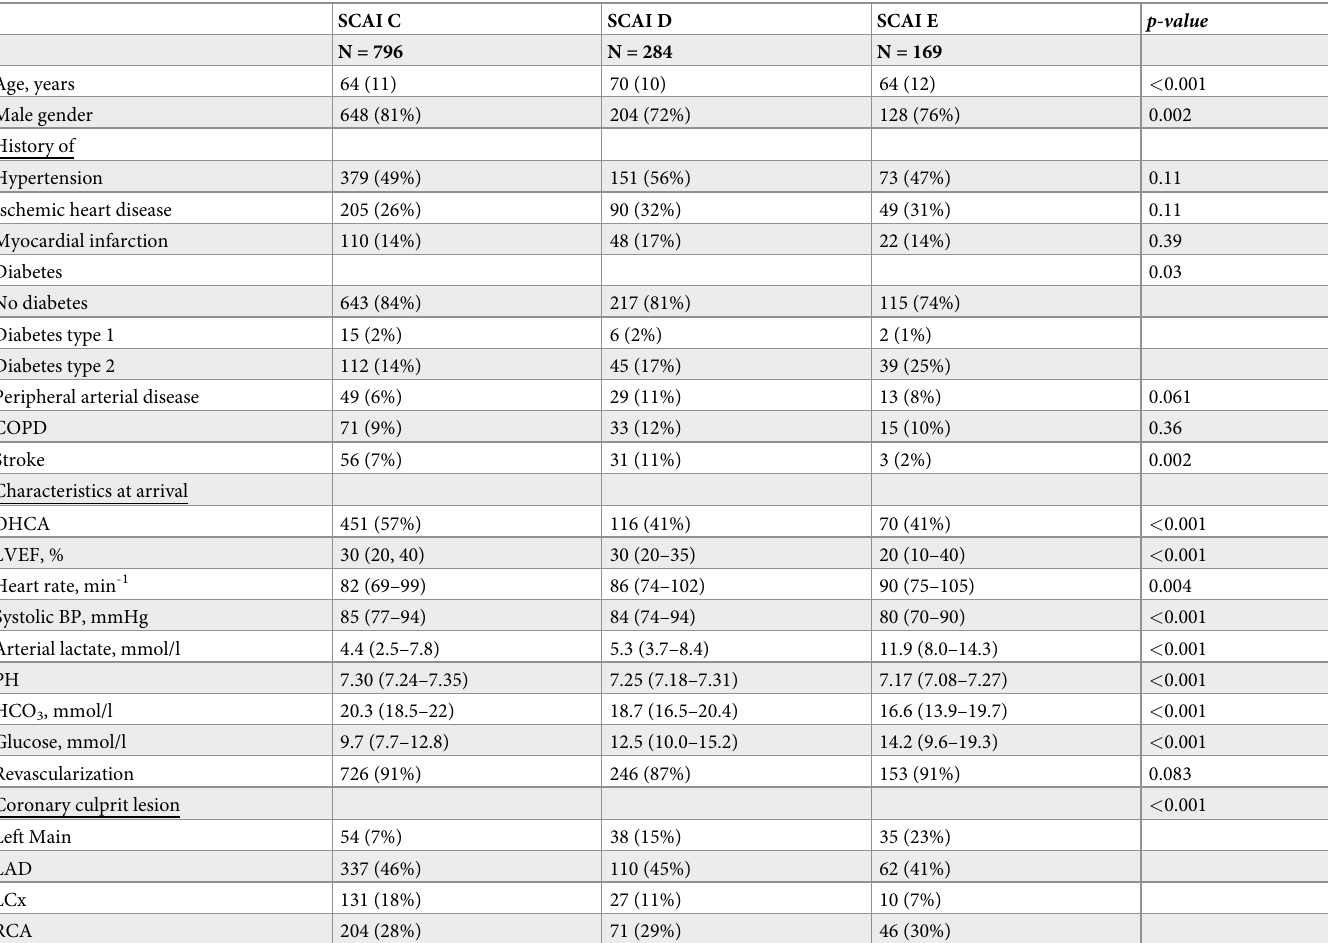
Table 2. Baseline characteristics of 1,249 AMICS patients with inopressor requirements at CICU. SCAI C SCAI D SCAI E p-value N = 796 N = 284 N =